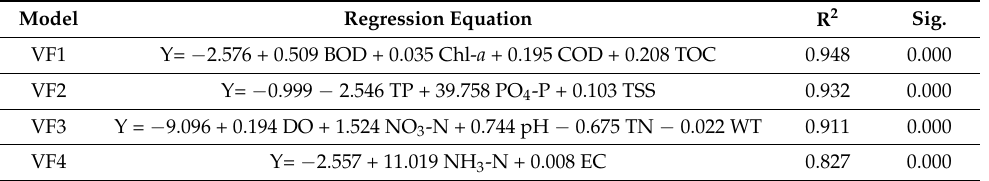
Table 6. Stepwise multiple linear regression model for